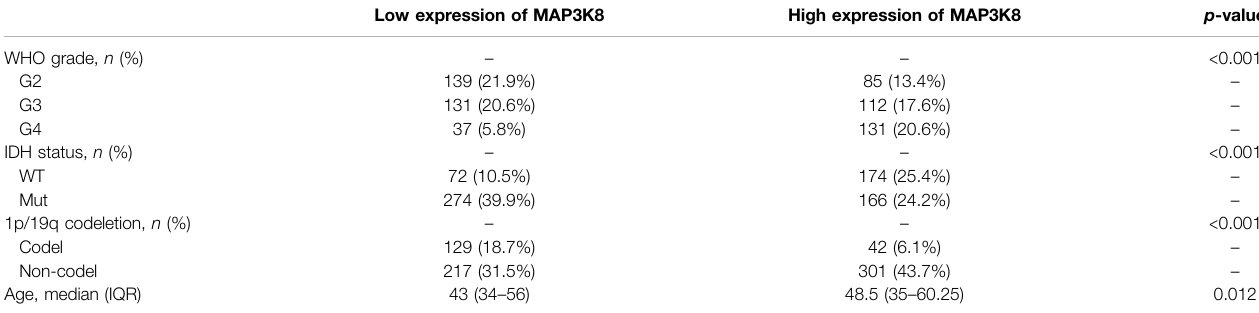
TABLE 1 | Association between MAP3K8 mRNA expression and the clinical parameters of glioma patients from The Cancer Genome Atlas (TCGA) Low expression of MAP3K8 High expression of